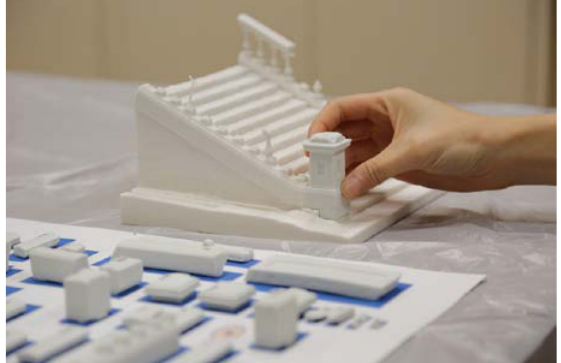
Figure 10: Miniature replicas of numbered granite fragments were 3D-printed and reassembled in the office.